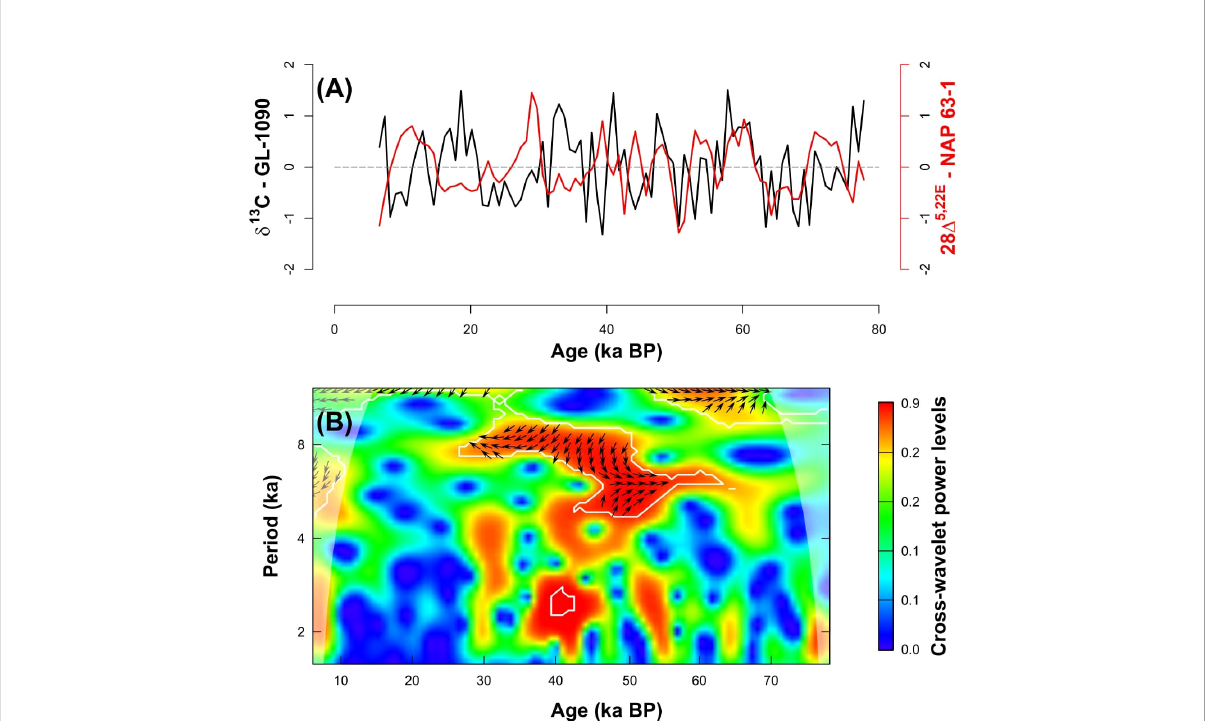
FIGURE 7 (A) Normalized time series of the stable carbon isotope from thermocline-dwelling foraminifera Globorotalia in fl ata from sediment core GL- 1090 (black line) (Nascimento et al., 2021) and 28 D 5,22E accumulation rates (ng cm − 2 year − 1 ; blue line) and (B) cross-wavelet analysis between them. The phase arrows in the cross-wavelet power spectrum rotate clockwise with a “ north ” origin. The vectors indicate the phase relationship, where in-phase signals point upward (N), and antiphase signals point downward (S). If X ( d 13 C) leads Y (28 D 5,22E ), arrows point to the right (E), and if X lags Y, an arrow points to the left (W). Marked regions on the wavelet spectrum indicate signi fi cant power to a 95% con fi dence interval, and areas under the translucid cone of in fl uence show where edge effects are important, and the analysis is